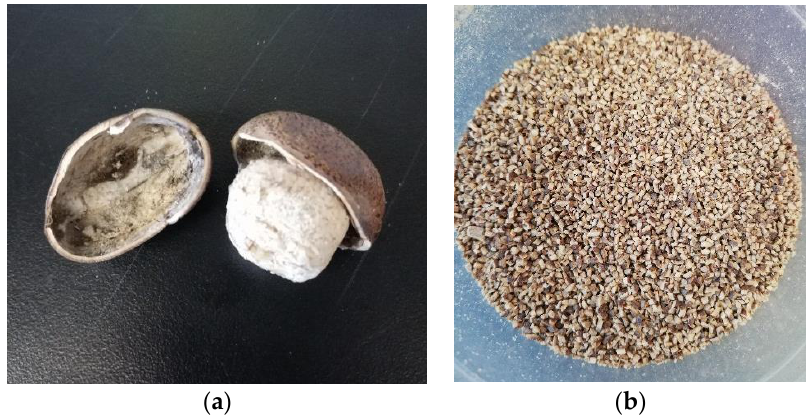
Figure 1. Image of raw ( a ) rubber seed shell (RSS) and ( b ) crushed RSS.